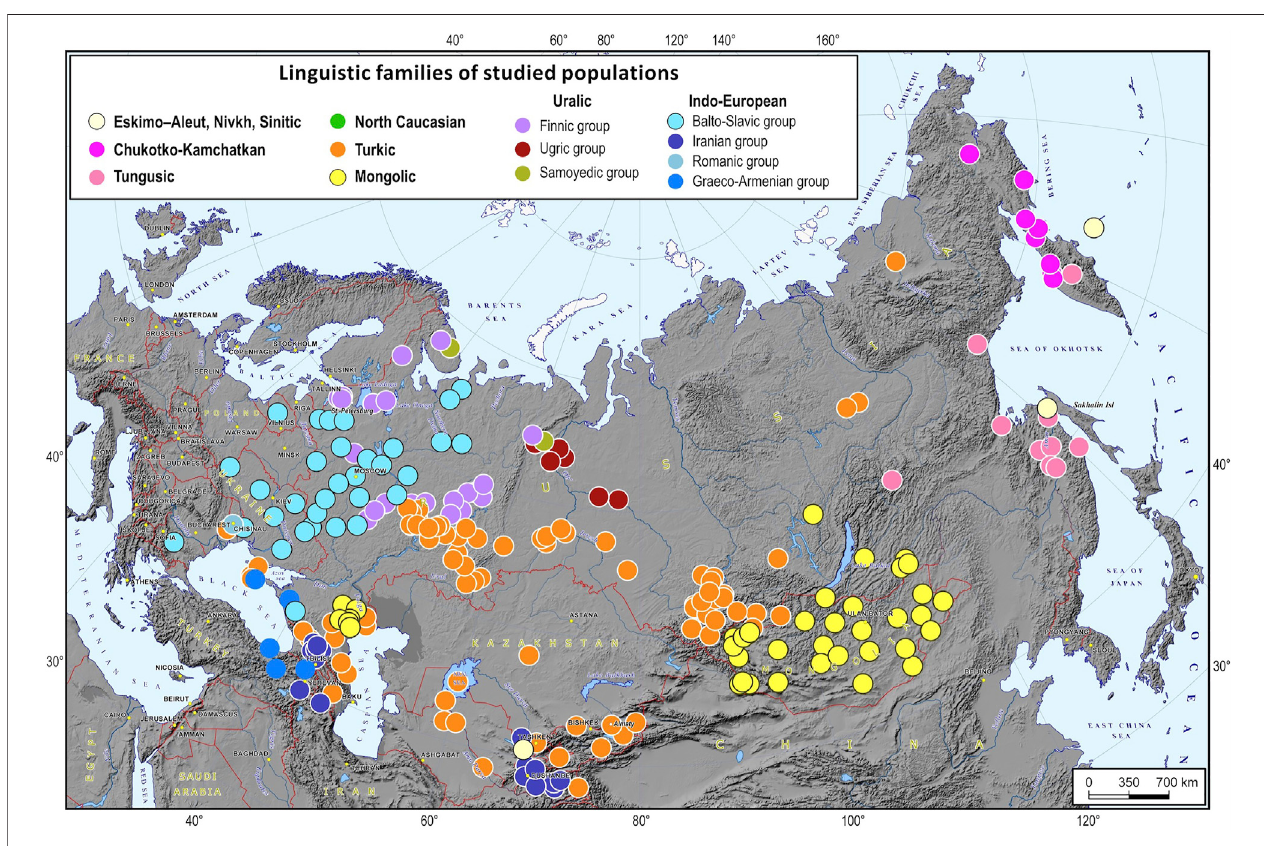
FIGURE 1 | A map of the 266 populations of North Eurasia used for the analysis. Notes. Dots of different colors on the map are languages spoken by the representatives of the studied populations (the color legend is provided at the top of the map).